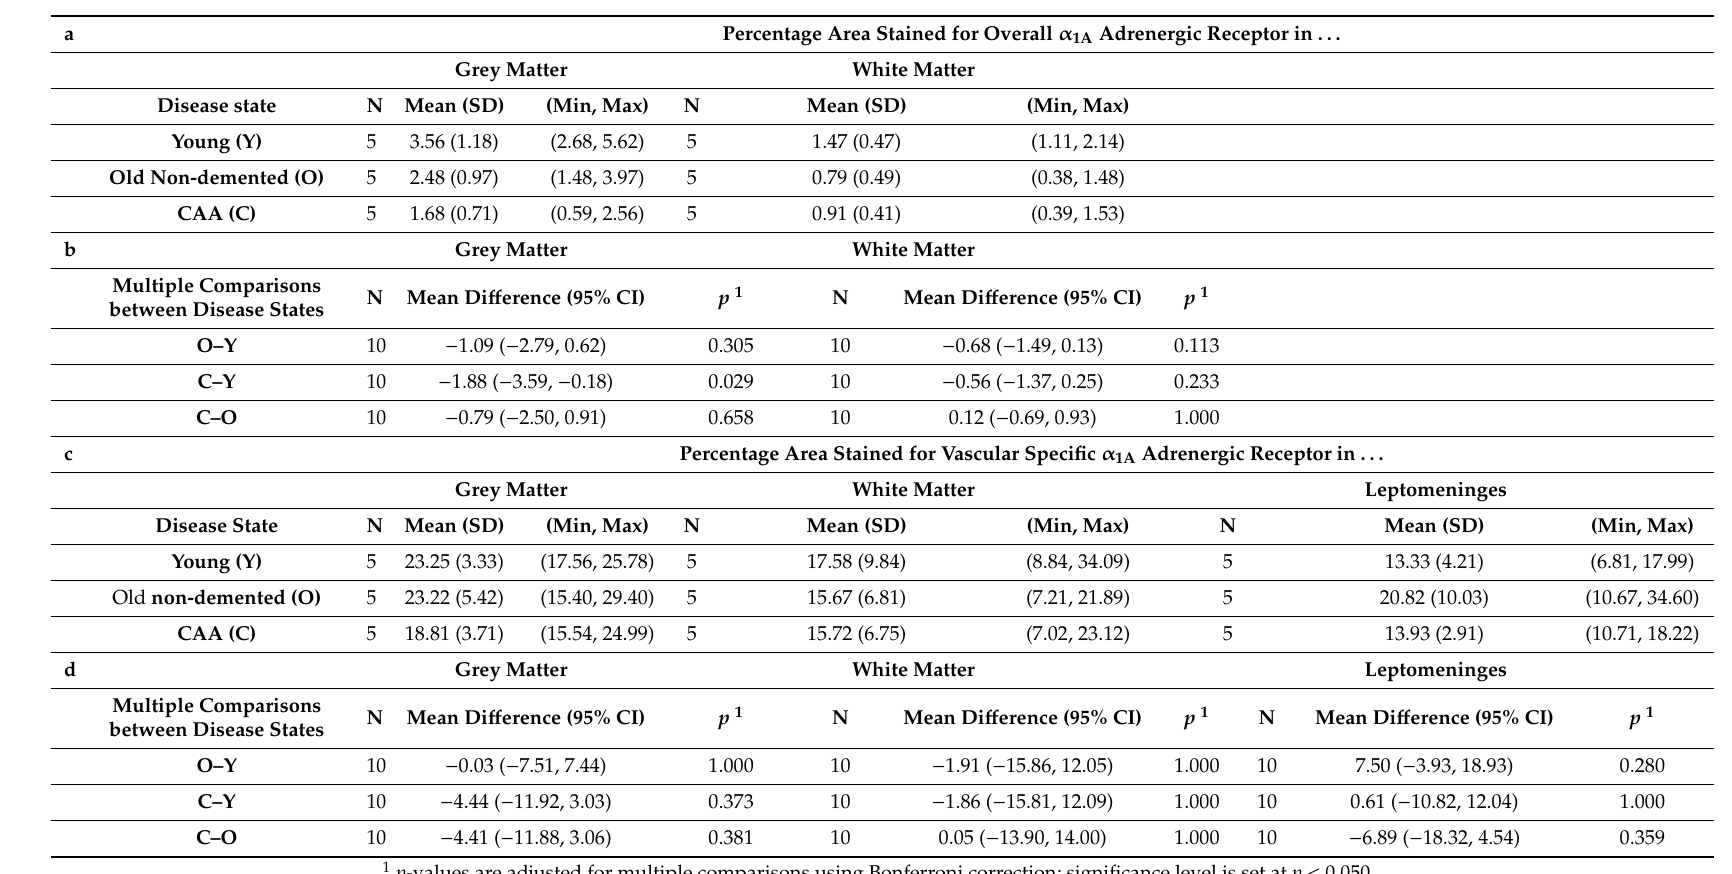
Table 1. Percentage area stained for overall and vascular specific α 1A adrenergic receptor in grey, white and leptomeninges per disease state and the comparisons between disease